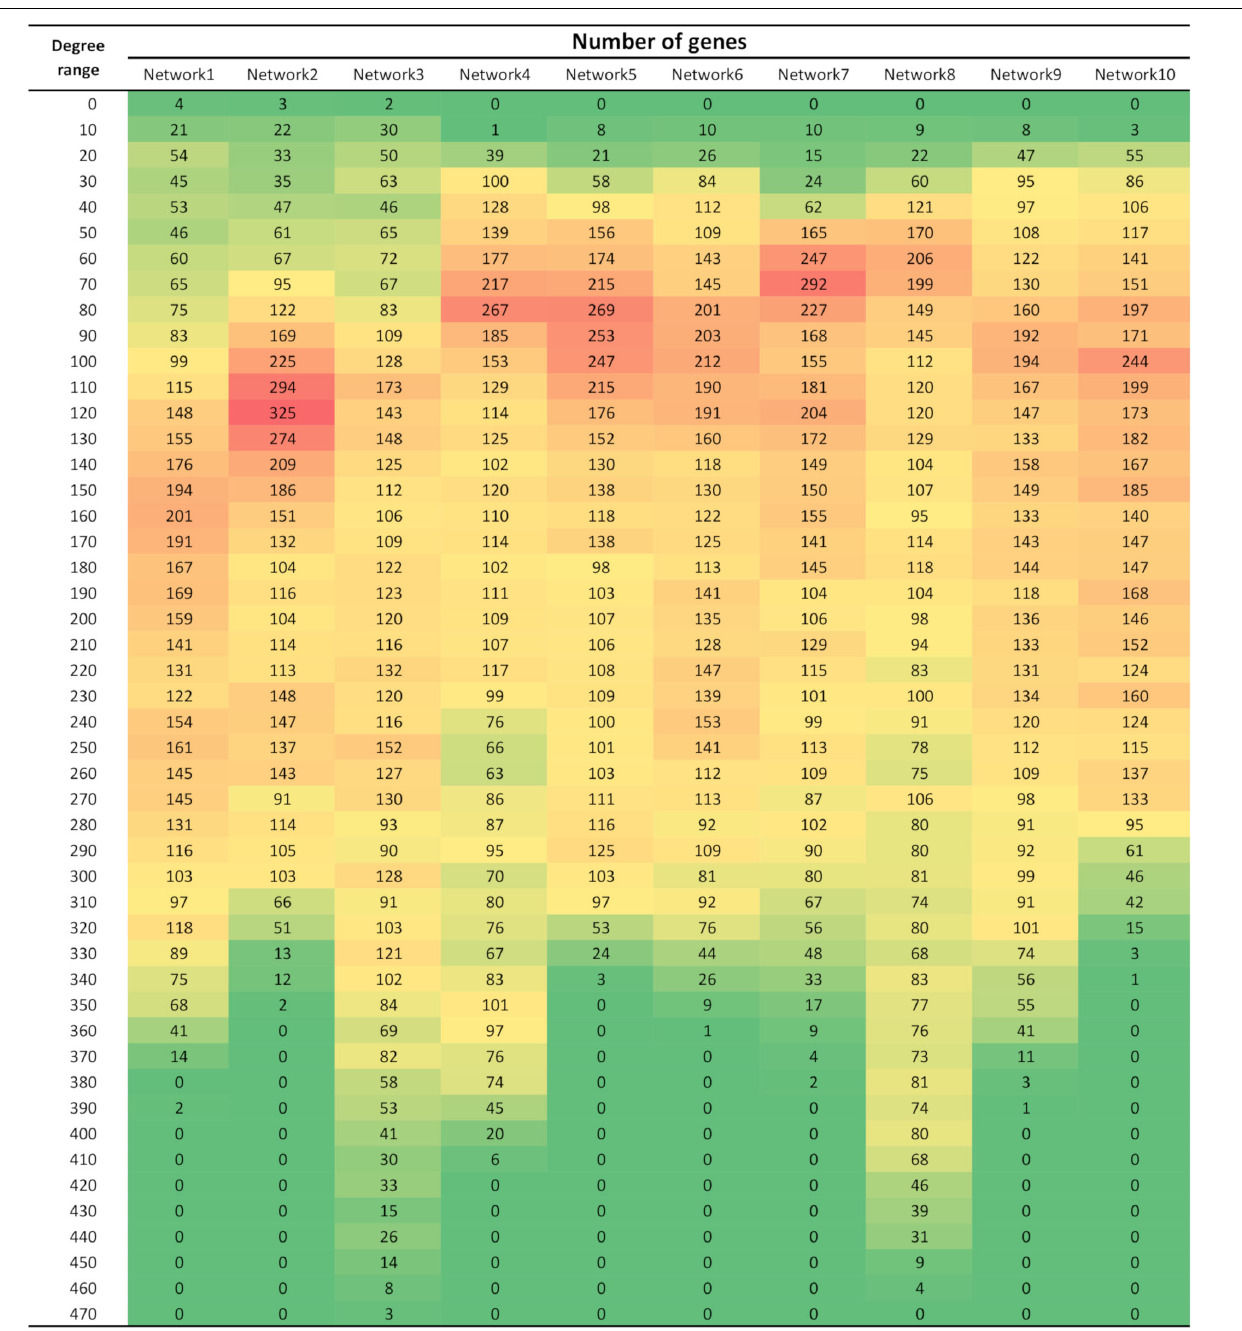
increase or decrease of their role in each particular